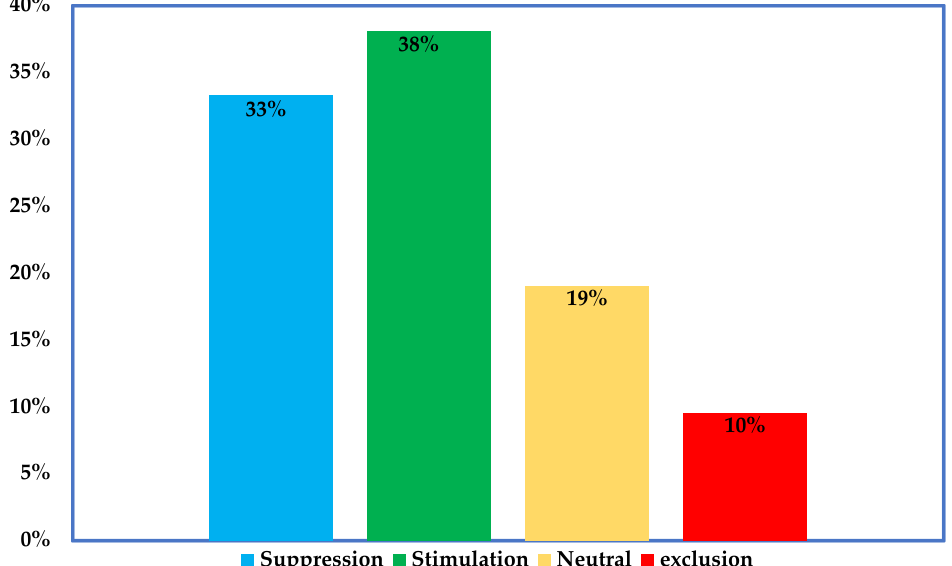
Figure 2. Impacts of inoculated strains on indigenous AMF under field condition. The figure was produced by case-by-case analysis of inoculants impacts as reported in the studies listed in Table 2. Table 1. Persistence of introduced AMF under field conditions. Criteria for selection are experiment in field and use of molecular tools to trace or monitor introduced AMF.